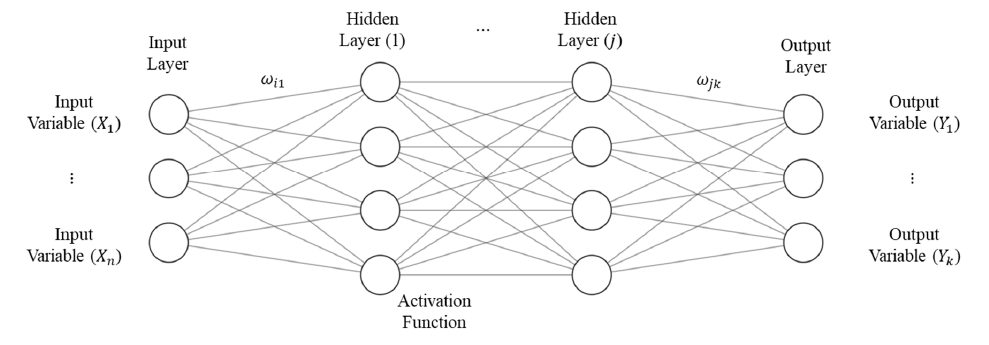
Figure 3. Topological structure of the backpropagation neural network (BPNN) model.